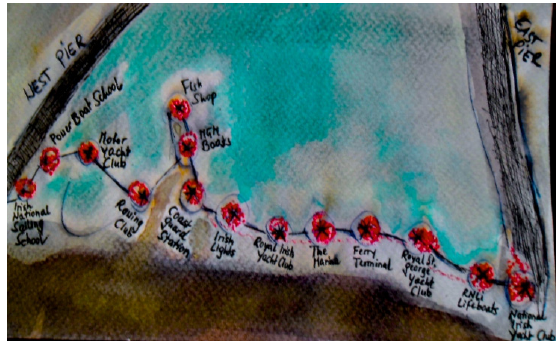
Figure 1. Map fragment, 2015. © Silvia Loeffler, Glas Journal,